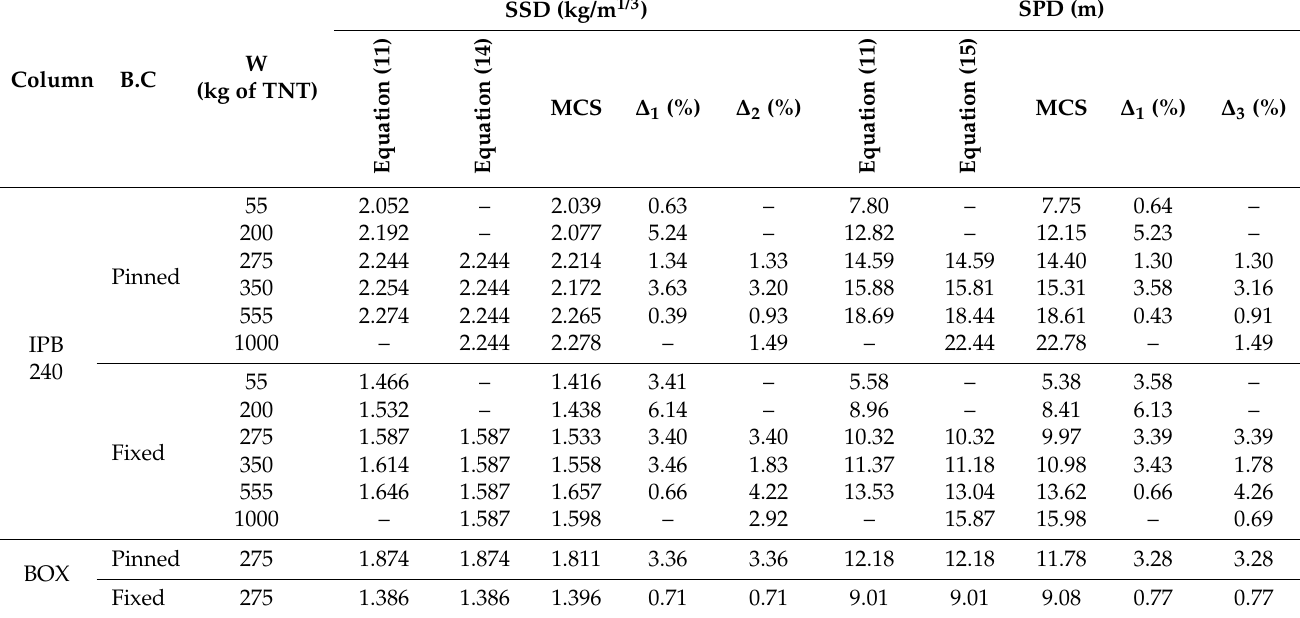
Table 6. SSD and SPD calculations with different methods MCS and proposed practical